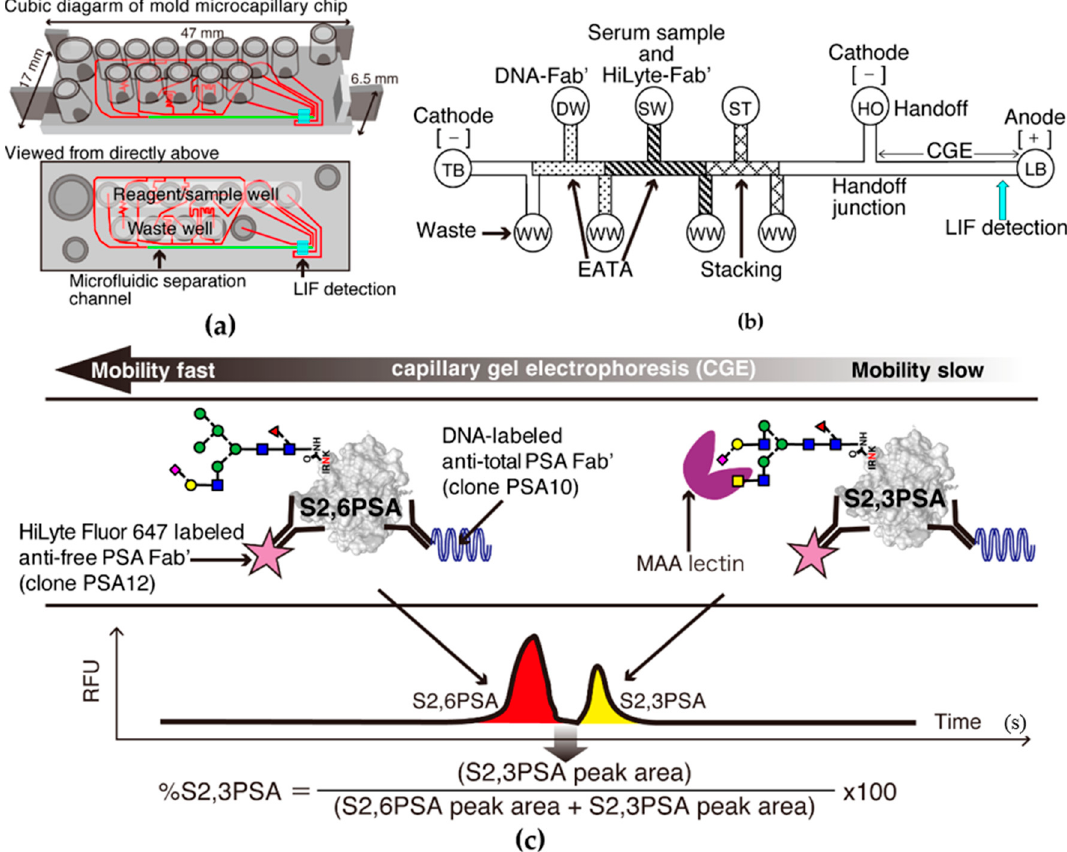
Figure 3. %S2,3PSA test using micro-total immunoassay systems ( μ TAS)-based microcapillary electrophoresis. ( a ) Molded plastic chip with top wells for reagents and precision microchannels on the bottom. Red line indicates microchannels. Highlight green line indicates microcapillary separation channel. Fluorescence signals are detected through the thin film closing the channels on the bottom of the chip; ( b ) Schematic diagram of a chip showing the electrokinetic analyte transport assay (EATA) method. Waste wells (WWs), trailing buffer (TB) well, leading buffer (LB), handoff (HO), DNA–labeled anti-total PSA Fab ′ (DNA–Fab ′ ) (DW), serum sample and HiLyte Fluor 647–labeled anti-free PSA Fab ′ (HiLyte–Fab ′ ) mixture (SW), and stacking buffer (ST) wells are shown. Vacuum applied to the WWs loads the reagents and sample-to-chip channel segments and voltage applied between cathode and anode mixes the sample and reagents for the binding reaction. Switching the voltage from the TB well to the HO well switches from isotachophoresis (ITP) stacking mode to capillary gel electrophoresis (CGE) mode. Separation of S2,3PSA from other glyco-isoform of free PSA occurs in the Mackkia amurensis lectin (MAA)-filled CGE separation channel prior to laser-induced fluorescence (LIF) detection. ( c ) Typical electropherogram of S2,6PSA and S2,3PSA peak separation. Fluorescent markers have been coelectrophoresed to identify the PSA protein peak positions (data not shown). RFU: relative fluorescence units.